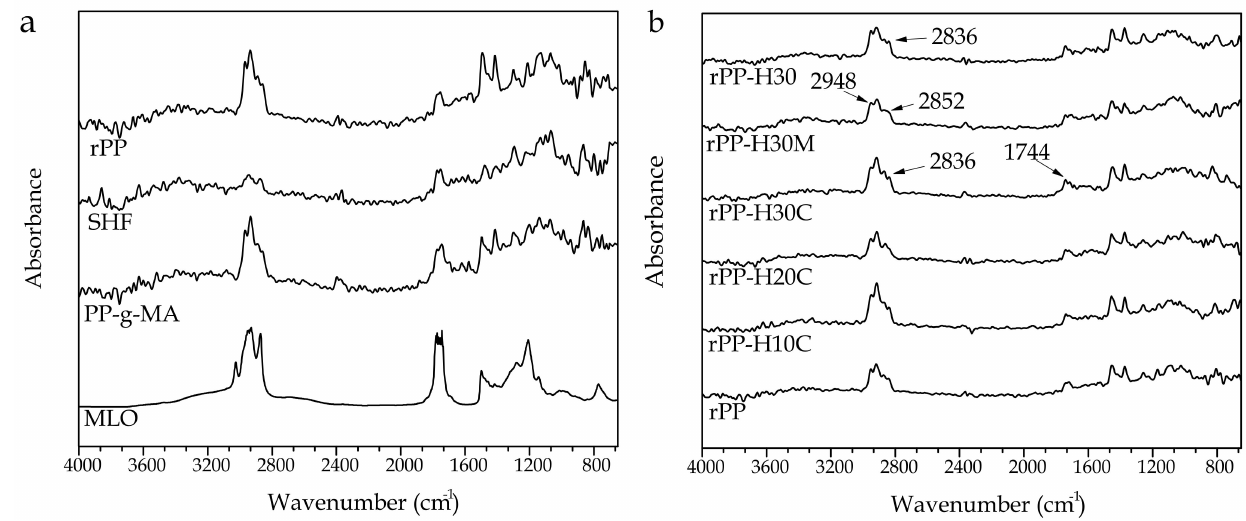
Figure 8. ( a ) Fourier-transform infrared (FTIR) spectra, from bottom to top, of rPP, SHF, PP-g-MA, and MLO; ( b ) FTIR spectra of the different